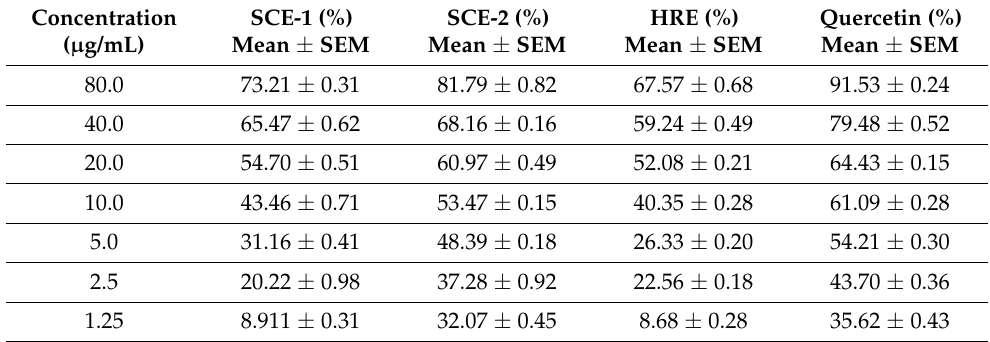
Table 2. α -glucosidase inhibition activity of extracts obtained from different extraction techniques.